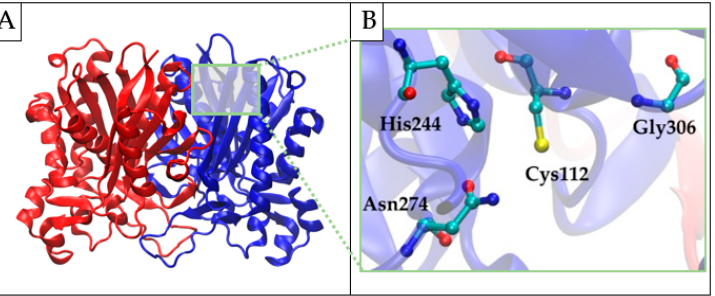
Figure 4. ( A ) Ec FabH apo dimer structure (PDB ID 1HN9). One FabH monomer is coloured in